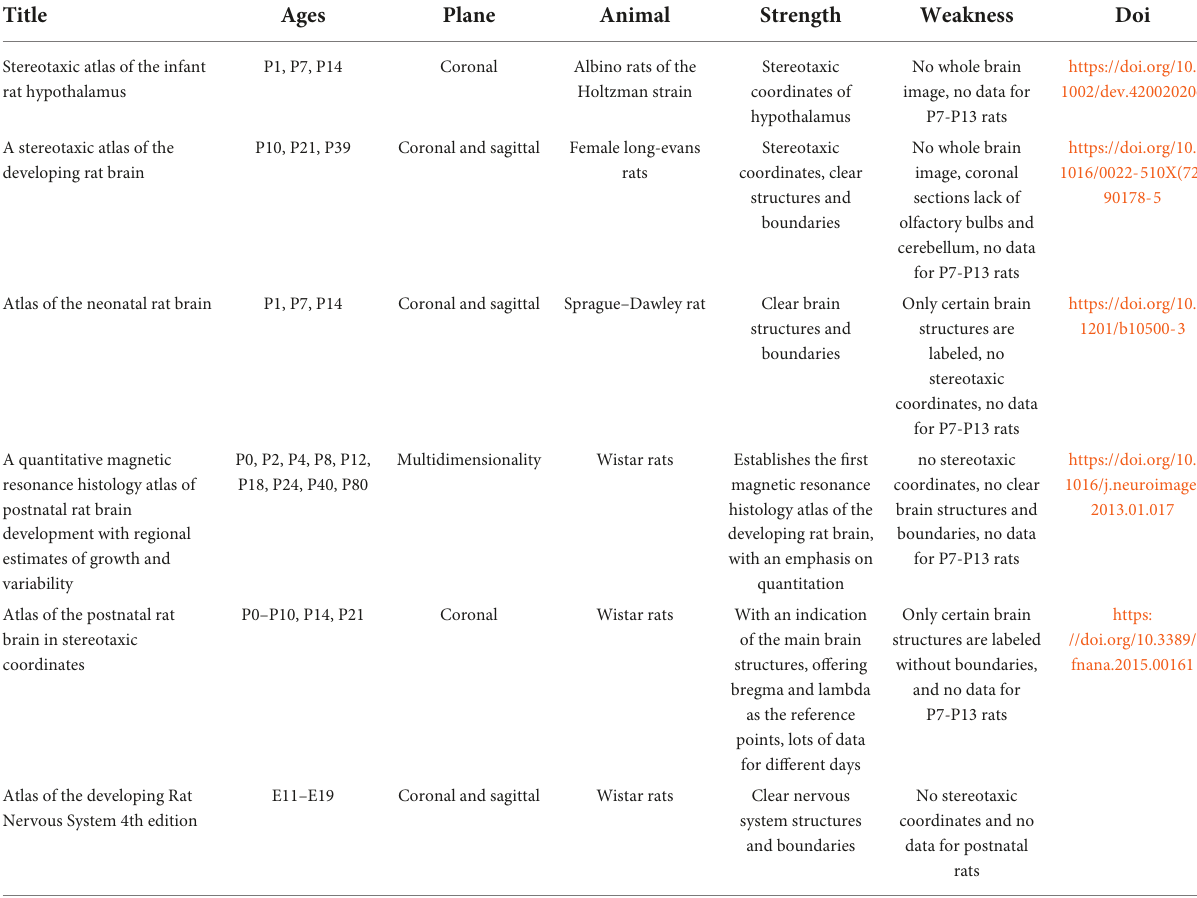
TABLE 1 Atlases of the developing rat